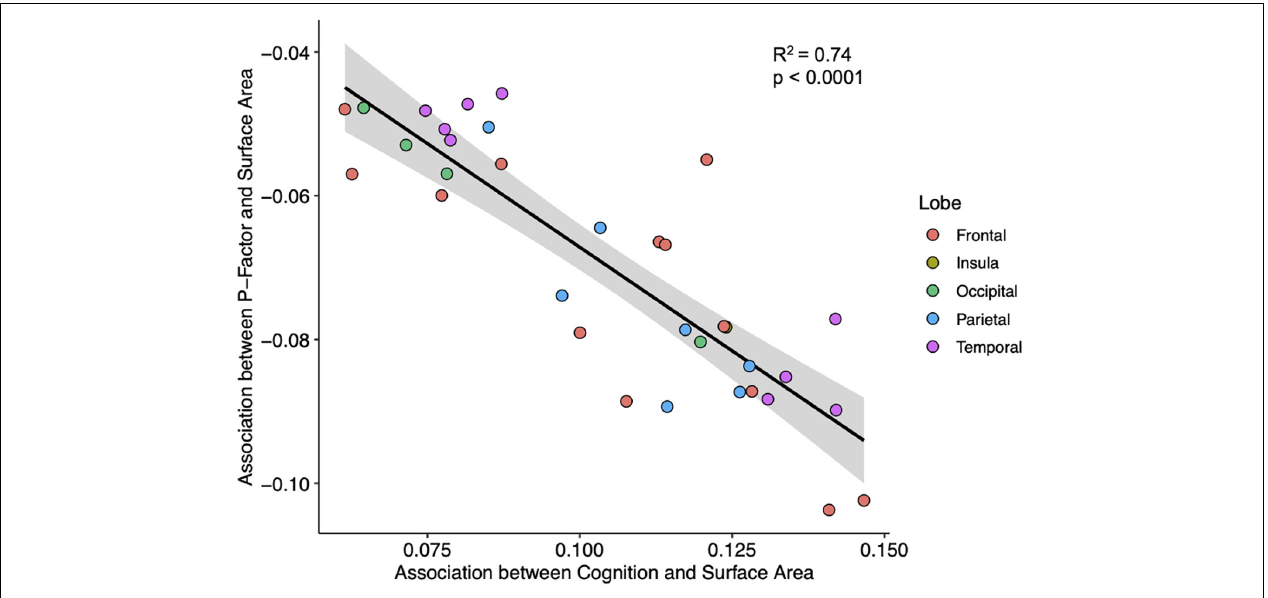
FIGURE 2 | A plot of interregional associations between the surface area and cognition ( x -axis) and interregional associations between the surface area and general psychopathology ( y -axis) across the 34 regions of the cerebral cortex. Each point represents 1 of the 34 cortical regions. Line and shaded portions represent, respectively, linear fit and 95% confidence interval for the linear fit. Pearson correlation = − 0.86, R 2 = 0.74, p <